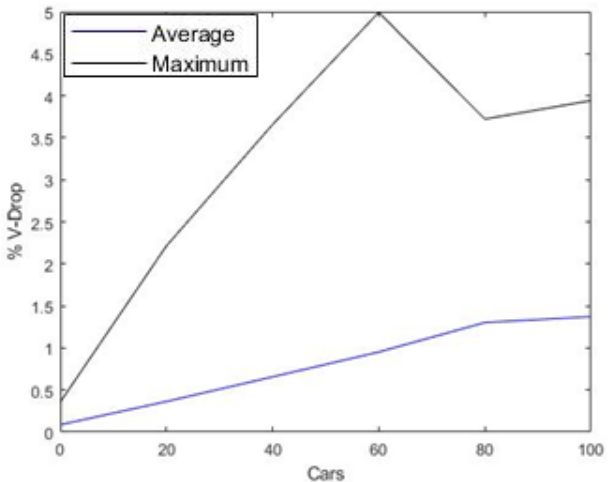
Figure 11. Maximum voltage drop (percentage) observed across the network over varying EV penetration versus the average voltage drop.